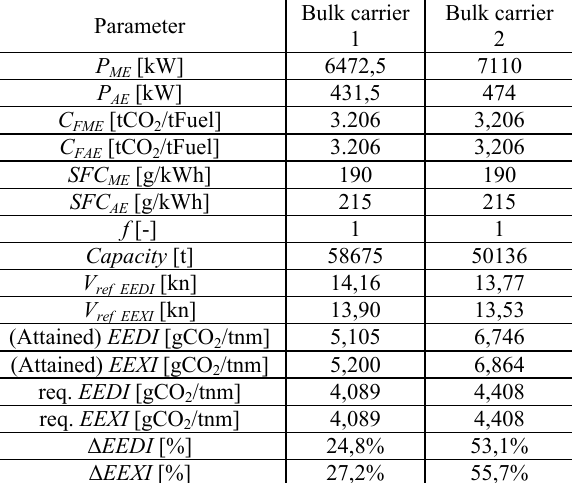
Table 4. Initial energy efficiency